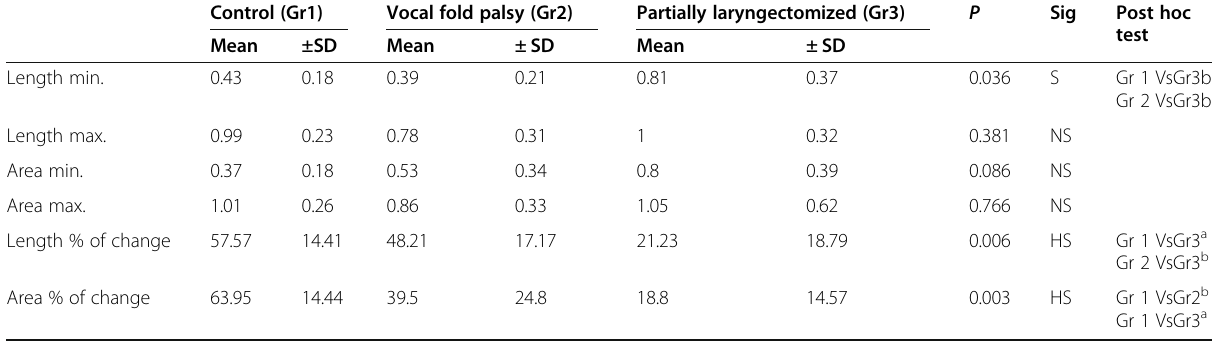
Table 1 Showing length min, length max, are max, percentage of length changes, and percentage of area changes Control (Gr1) Vocal fold palsy (Gr2) Mean ±SD Mean ± SD Mean ± SD Length min. Length max. Area min. Area